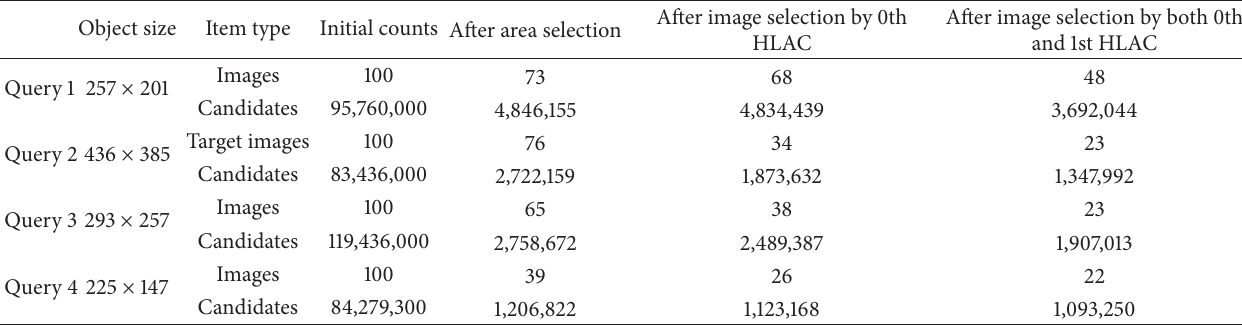
Table 2: Transitions in numbers of target images and candidates during two